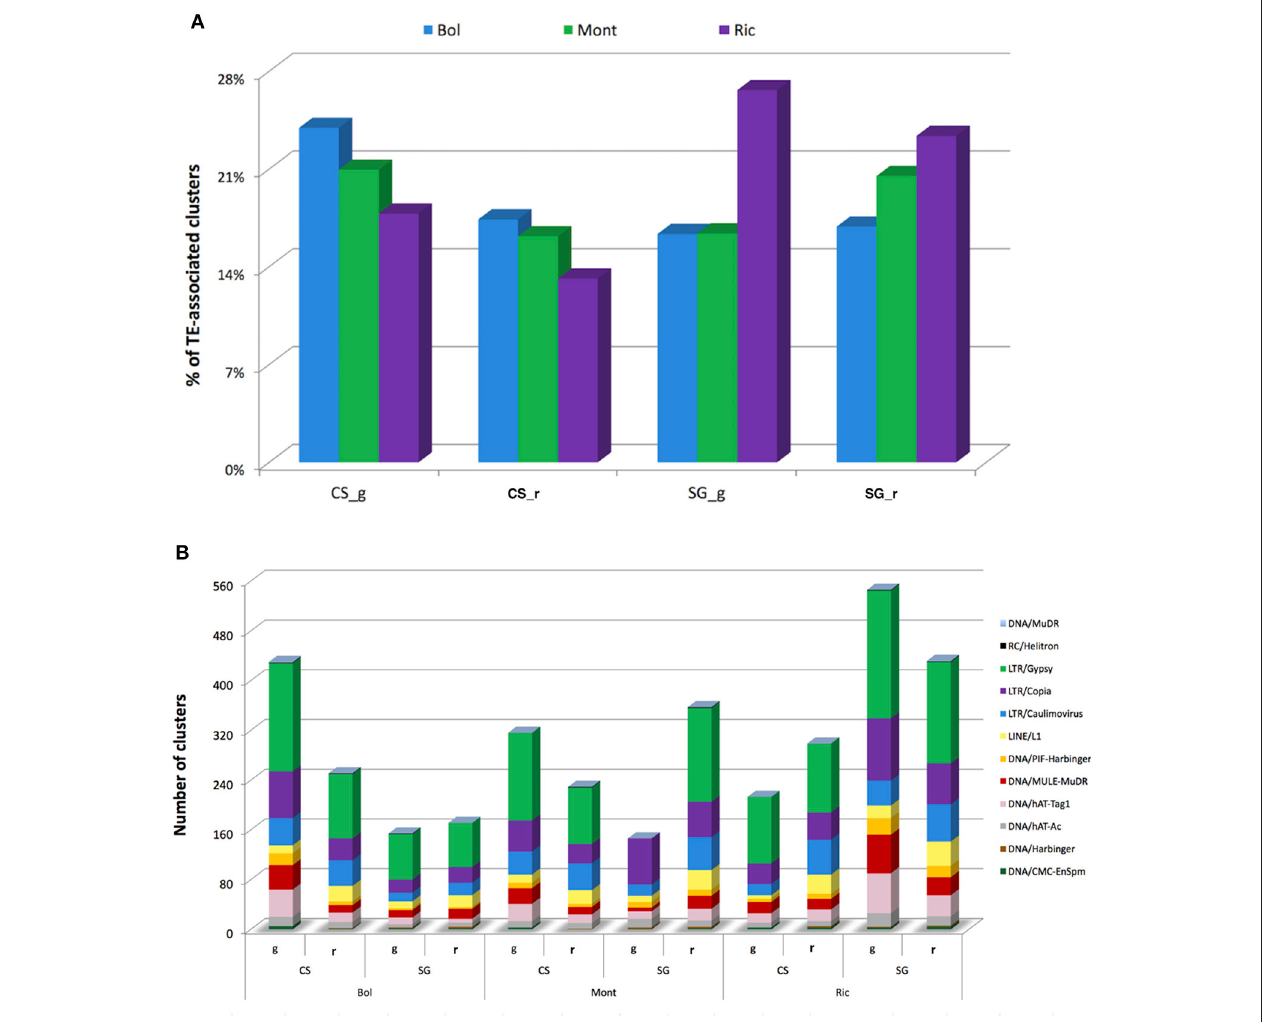
FIGURE 3 | Profile of small RNA-producing clusters expressed in ripened and green berries of grapevine collected from 2 different cultivars growing in 3 vineyards associated with Transposable Elements (TE). (A) Percentage of sRNA-producing clusters associated with TE in each sample. (B) Number of small RNA-generating clusters associated with different classes of TE in different samples. Bol, Bolgheri; Mont, Montalcino; Ric, Riccione; CS, Cabernet Sauvignon; SG, Sangiovese; g, green; r, ripened. Green corresponds to bunch closure and ripened corresponds to 19 ◦ Brix developmental